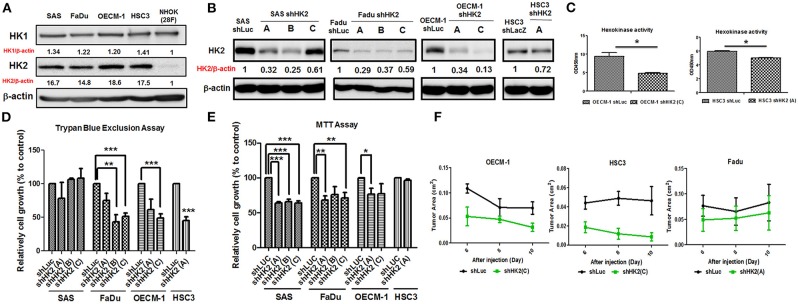
Differential HNSCC cell growth and HNSCC-bearing xenografic tumor growth in response to HK2 loss. Respective Western blot analysis for HK1 and HK2 protein expression in (A) HNSCC and NHOK cells and (B) shRNA-mediated HK2-silencing HNSCCC cells. (C) Colorimetric hexokinase activity assay showed functional deficient in HK2-silencing OECM-1 and HSC3 cells. Cell growth was examined in HK2-silencing HNSCC cells using (D) trypan exclusion and (E) MTT assays. (F) HK2 loss downregulated HNSCC-bearing xenografic tumor growth. shLuc vector is used as a control plasmid. Data are shown as mean ± SEM (N ≥ 3). ***p < 0.001, **p < 0.01, and *p < 0.05.